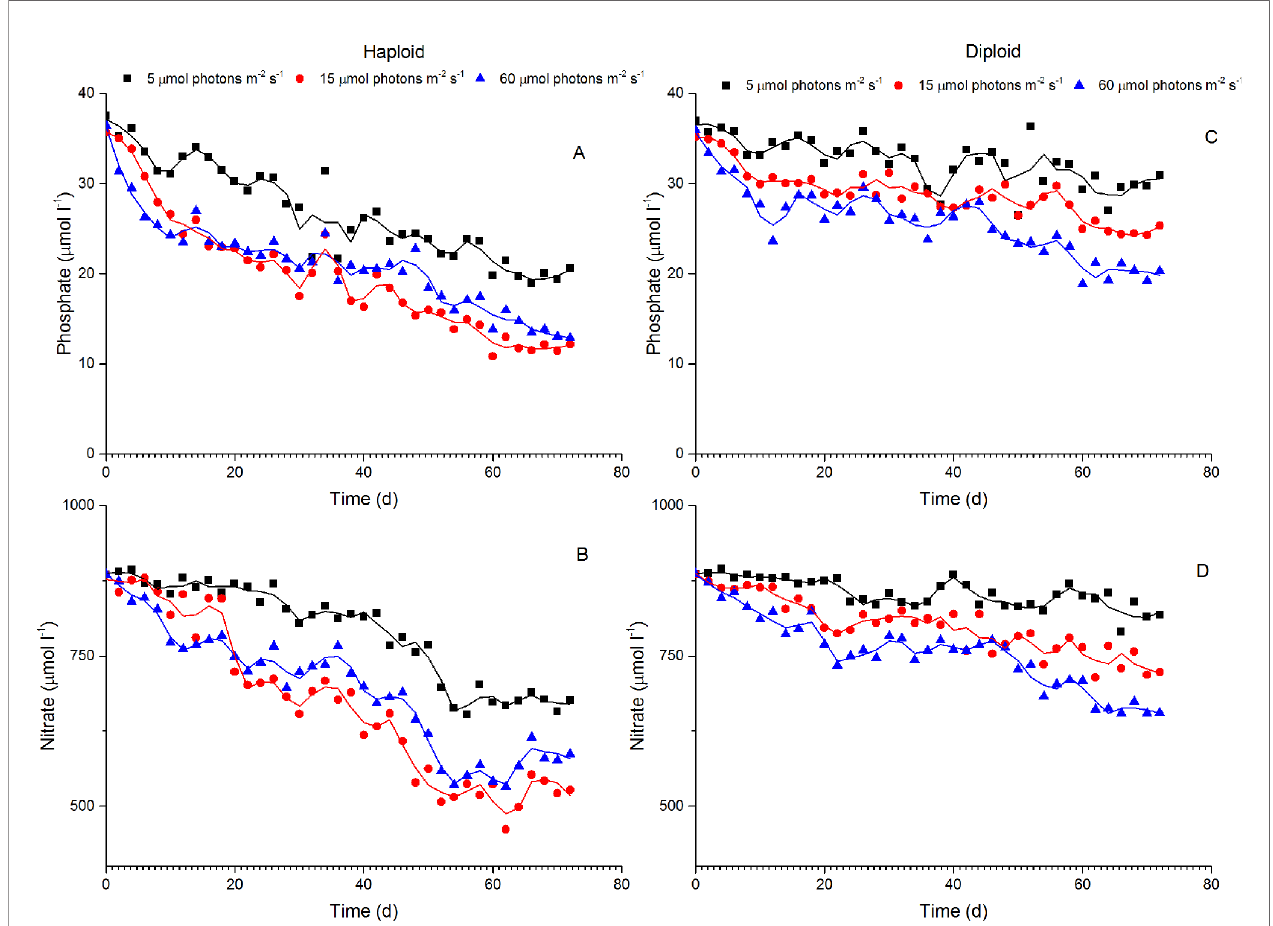
FIGURE 4 | Variations in phosphate and nitrate concentrations in the culture of haploid and diploid cells of P. globosa under different light intensities. (A, B) phosphate and nitrate concentrations in haploid cultures; (C, D) phosphate and nitrate concentrations in diploid cultures.